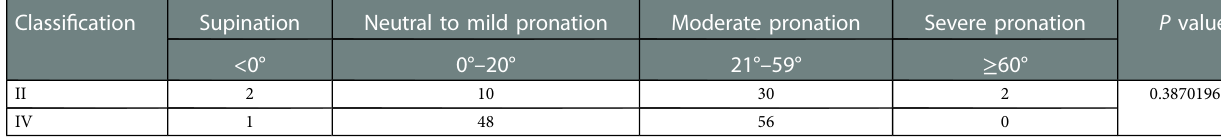
TABLE 3 T-test on the distribution of II and IV patients in C&O classi fi